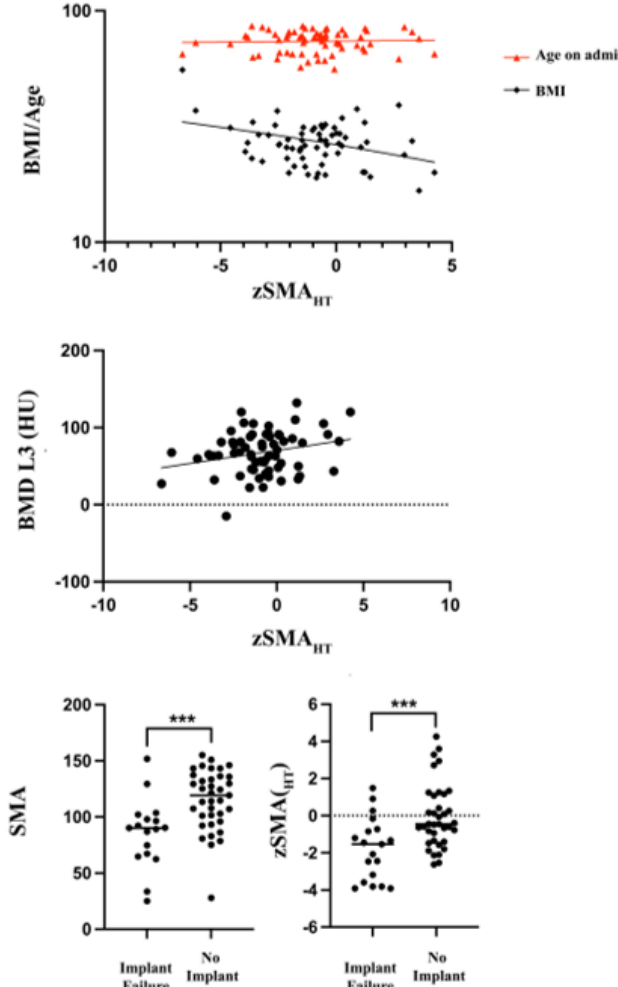
Figure 2. Correlation of zSMA HT with age/BMI (top) and BMD L3 (middle). Association of SMA (lower left) and zSMA HT (lower right) with implant failure. *** p ≤ 0.001.